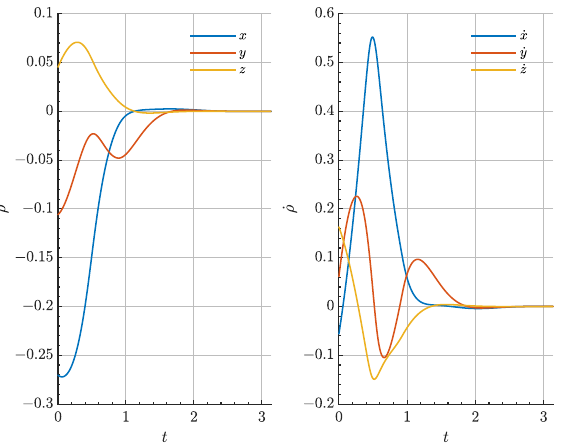
Figure 20. Relative state evolution for the Lunar Gateway resupply mission during the long-range rendezvous.